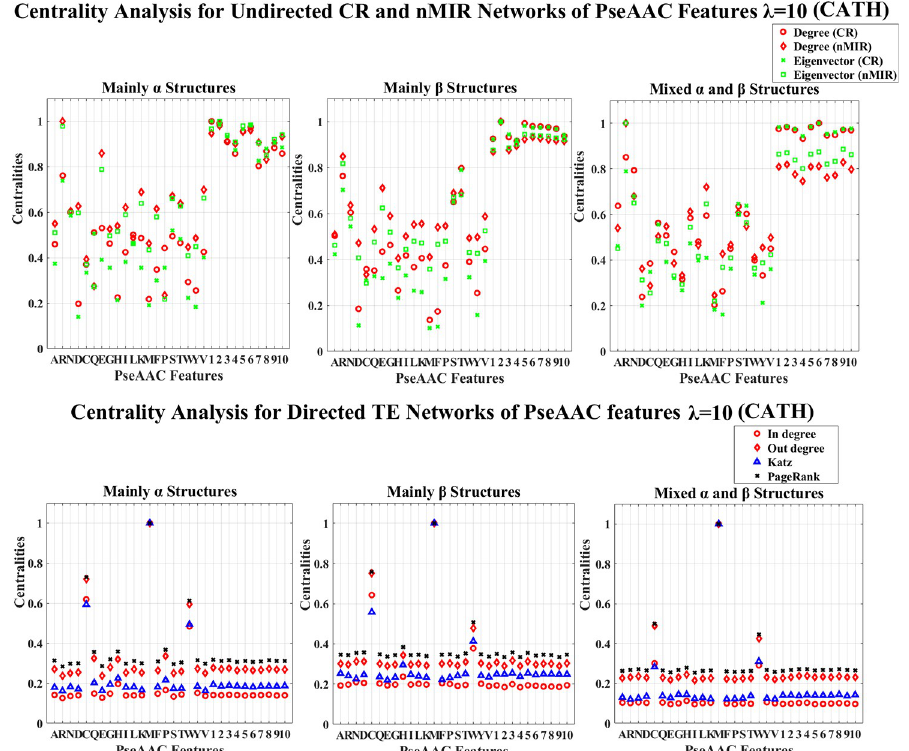
Fig 6. Centrality analysis for the networks of D features (SCOP). This figure shows the centrality results for the networks of D features (SCOP